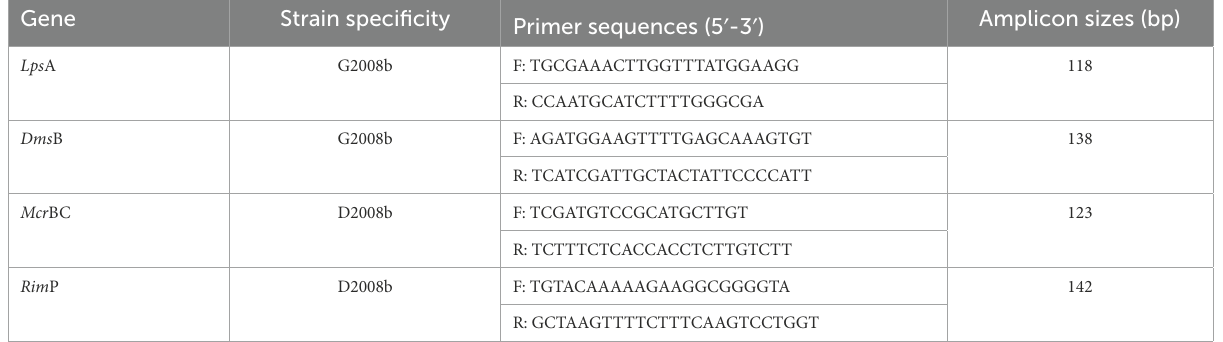
TABLE 1 Primer sequences used for strain specific PCR and qPCR. Gene Strain